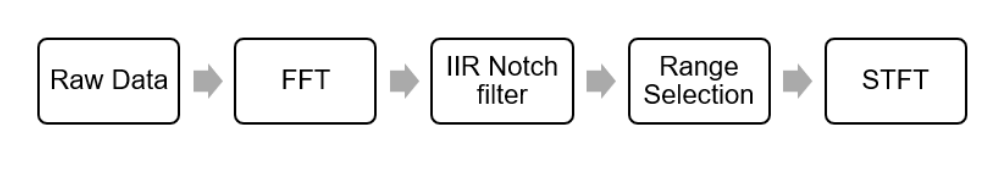
Figure 2. Block diagram of signal